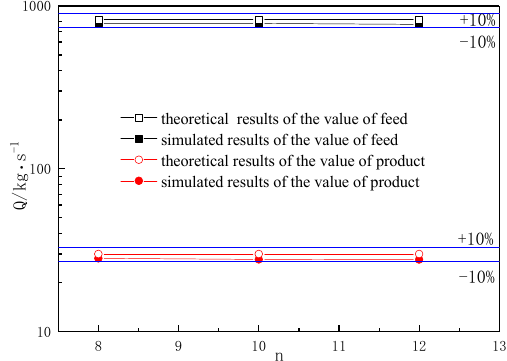
Figure 4. The comparison of the theoretical and simulated results of the value of feed and product in the enlarged cerium chloride reactor.